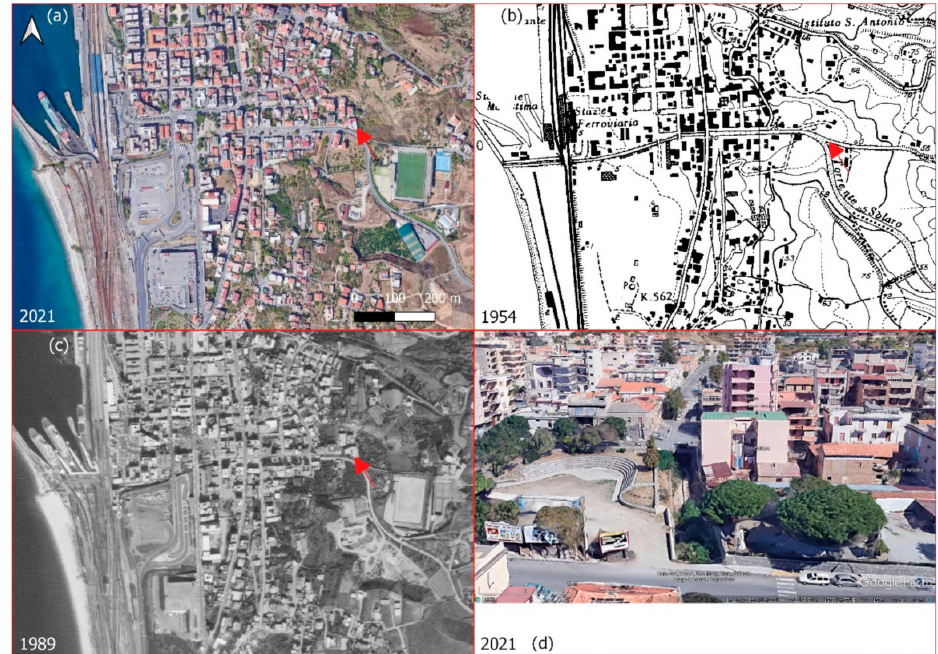
Figure 10. The Solano River. ( a ) An image of Google Earth from September 2021. ( b ) The CASMEZ cartography from 1954. ( c )The orthophoto from 1989. ( d ) The view of the culvert towards upstream (source: Google Earth). The arrows identify the upstream section of the